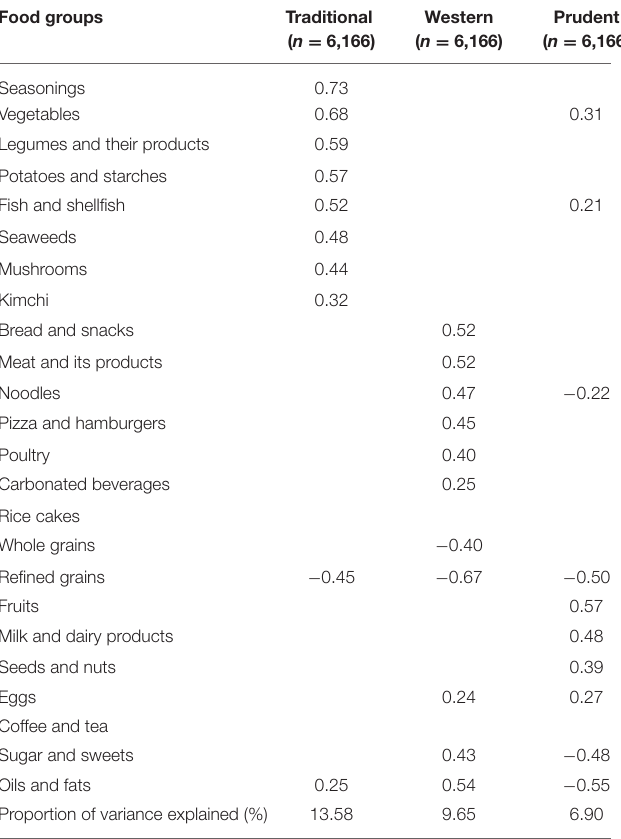
TABLE 3 | Factor loading matrix for three dietary patterns identified by factor